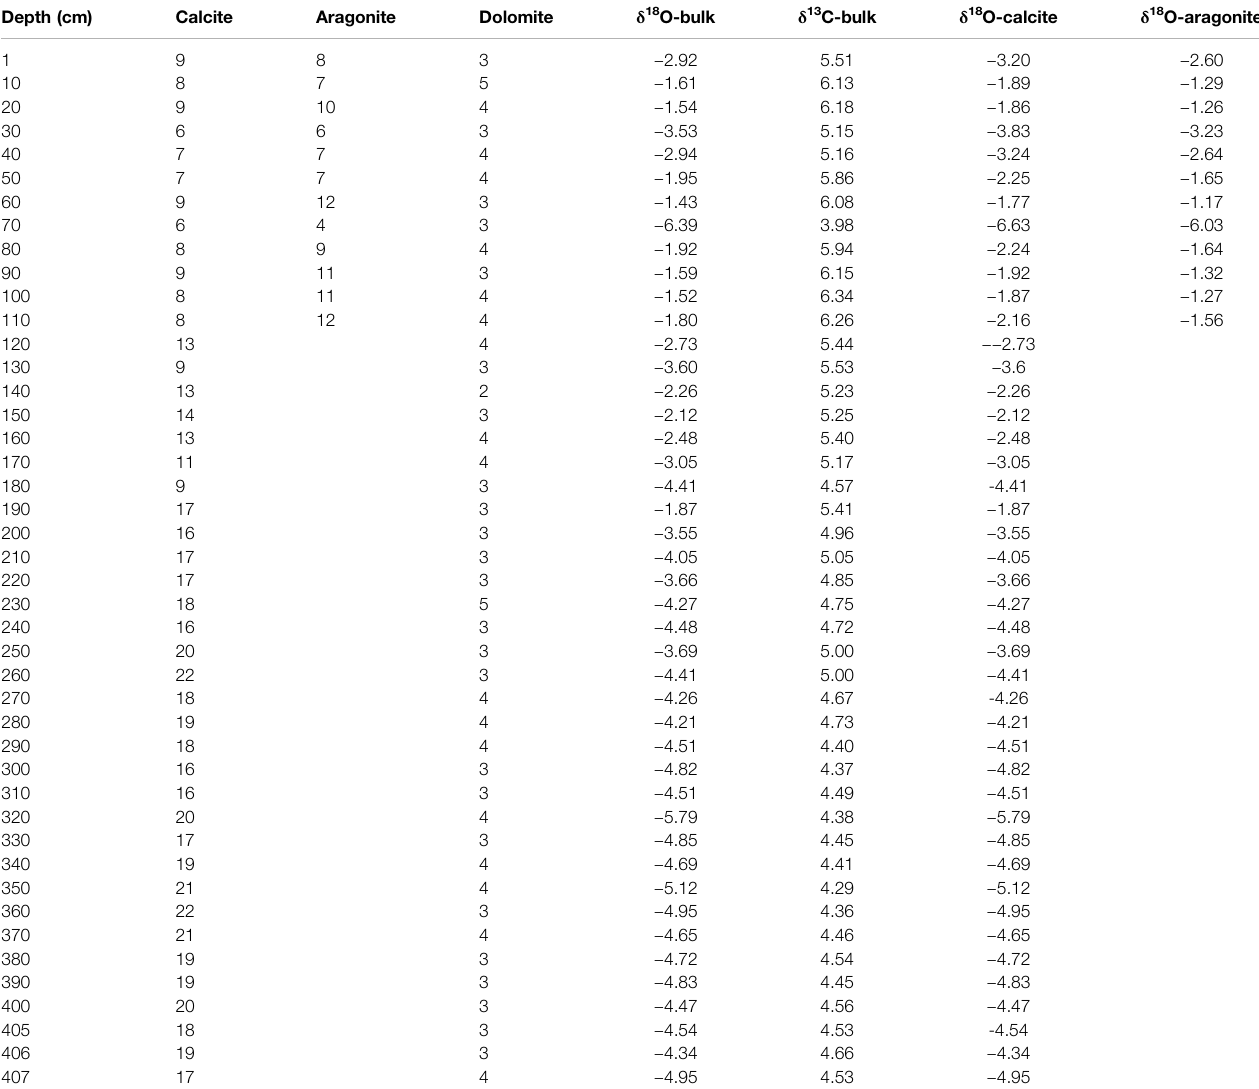
TABLE 3 | Mineral content (%) and isotopic composition ( ‰ VPDB) Depth